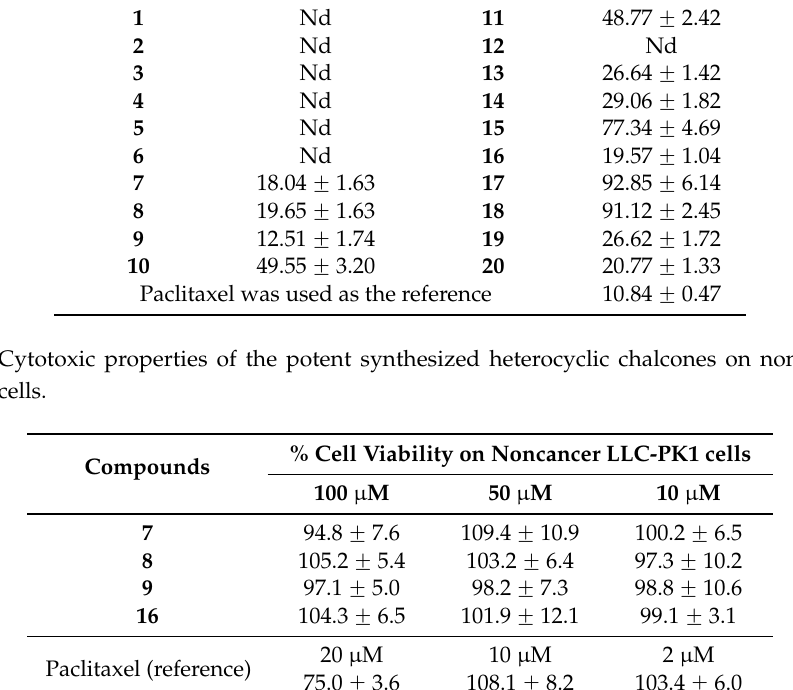
Table 3. Cytotoxic profile of the potent synthesized heterocyclic chalcones on RMS cells. Compounds